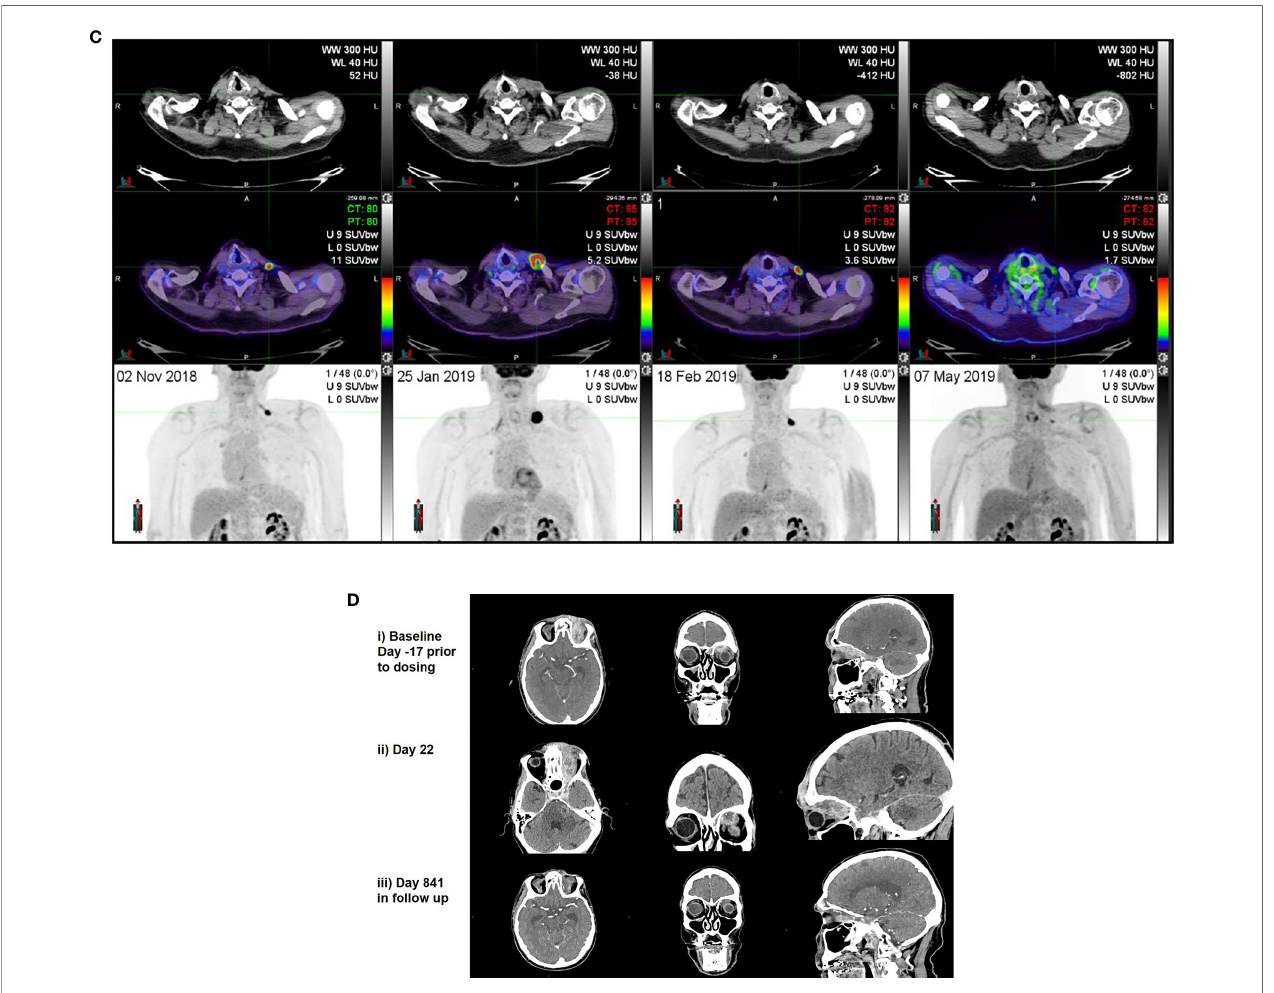
FIGURE 1 | Correlative clinical photographs, tumor response measurements according to time, and fl uorodeoxyglucose - positron emission tomography (FDG-PET) and CT scan images of discussed patient cases. (A, B) Patient One ’ s photographic images demonstrating iUPD and iCPD, with accompanying tumor response measurements according to RECIST 1.1 and immune based criteria at key time points. (C) Patient Two ’ s FDG-PET images over time with low dose axial CT, fused axial CT, and maximal intensity projection (MIP) images in each column from 02/NOV/2018, 25/JAN/2019, 18/FEB/2019, and 07/MAY/2019, demonstrating evidence of progression and regression with ongoing immunotherapy. (D) Patient Three ’ s representative images of disease at baseline, at progression and with response. Images i) Baseline (Day-17 prior to dosing) Post contrast CT: (axial, coronal, sagittal) demonstrates enhancing soft tissue extending from the cutaneous left forehead along the roof of the left orbit in the distribution of V1, involving the cavernous sinus, Meckel ’ s cave, nerve root entry zone of the left trigeminal nerve and likely involvement of the trigeminal nuclei with soft tissue at the left pons. ii) Day 22 Post contrast CT: (axial, coronal, sagittal) demonstrates increasing volume of enhancing soft tissue extending from the cutaneous left forehead along the roof of the left orbit in the distribution of V1, involving the cavernous sinus, Meckel ’ s cave, nerve root entry zone of the left trigeminal nerve and involvement of the trigeminal nuclei with soft tissue at the left pons. iii) Day 841 (in follow up) Post contrast CT: (axial, coronal, sagittal) demonstrates small volume residual non-enhancing soft tissue extending from the cutaneous left forehead along the roof of the left orbit. The remaining soft tissue has resolved on